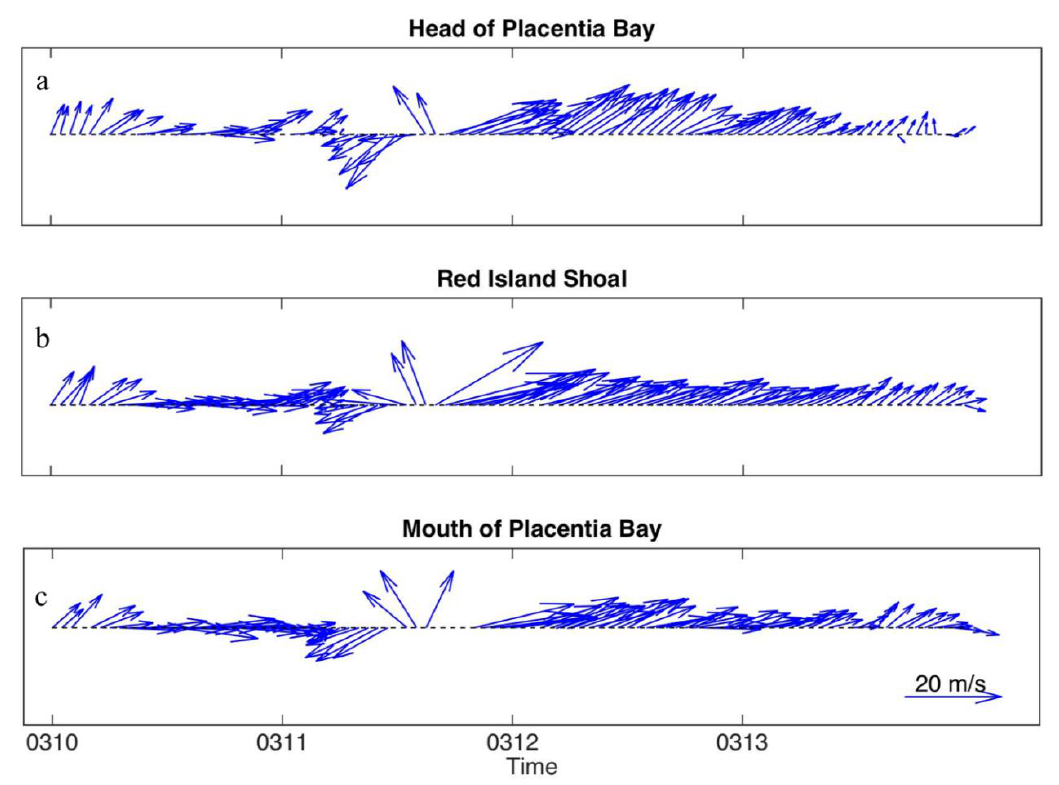
Figure 4. Hourly wind vectors (m s − 1 ) from buoys at HP ( a ), RI ( b ), and MP ( c ) from 10 to 13 March 2017.